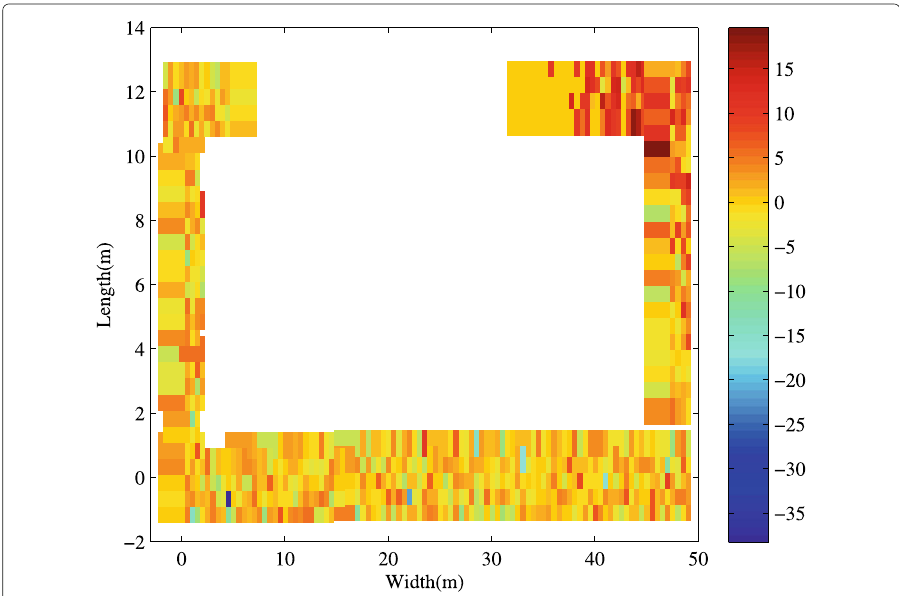
Fig. 14 Error of radio map built by step-counter-assisted method